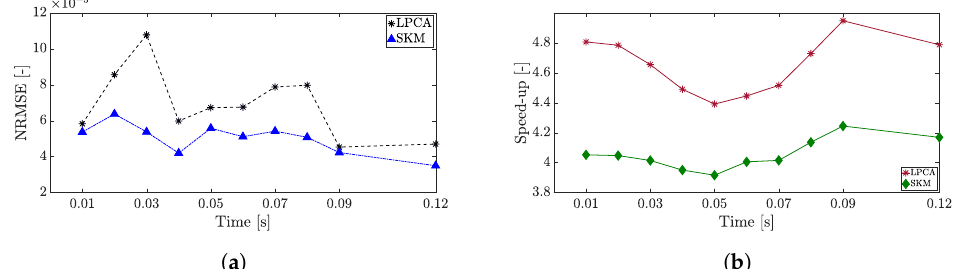
Figure 9. Comparison between the unsteady adaptive simulations obtained with a sinusoidal perturbation in the fuel velocity profile ( f = 10 Hz and A = 0.25) using the reduced mechanism ( (cid:101) DRGEP = 0.005) generated from the SKM partitioning and the LPCA partitioning: ( a ). Averaged normalized root mean square error over time; ( b ). Speed-up factor compared to detailed simulation over